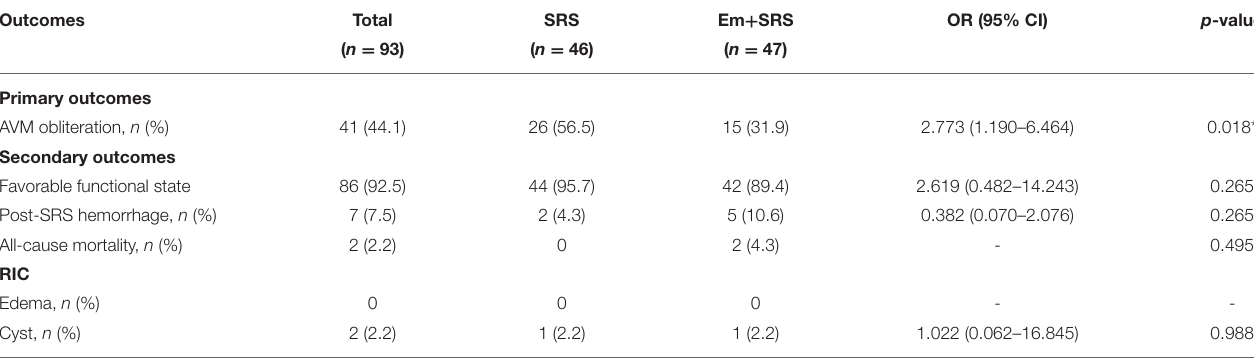
TABLE 3 | Primary and secondary outcomes in the ruptured subgroup.